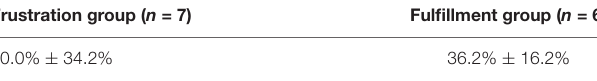
TABLE 5 | Level of altruistic behavior (Mean and SD ) by group.